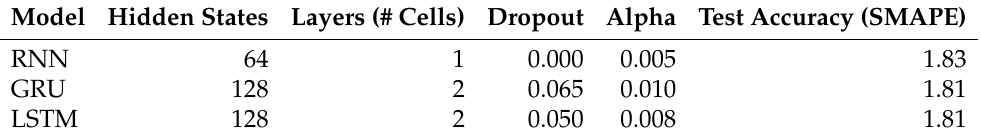
Table 1. Hyperparameters and test accuracy for the various RNN architectures.